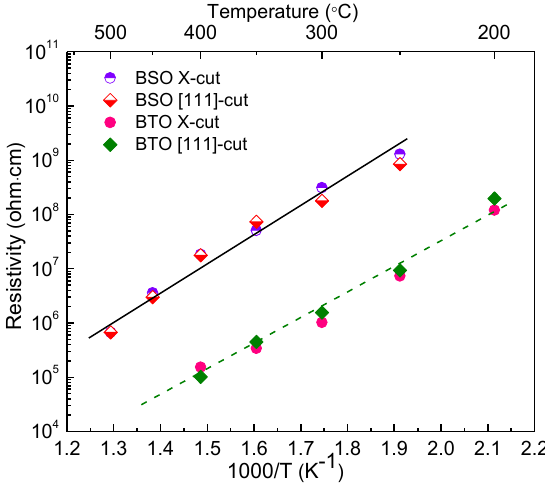
Figure 5. Resistivity as a function of temperature for BTO and BSO